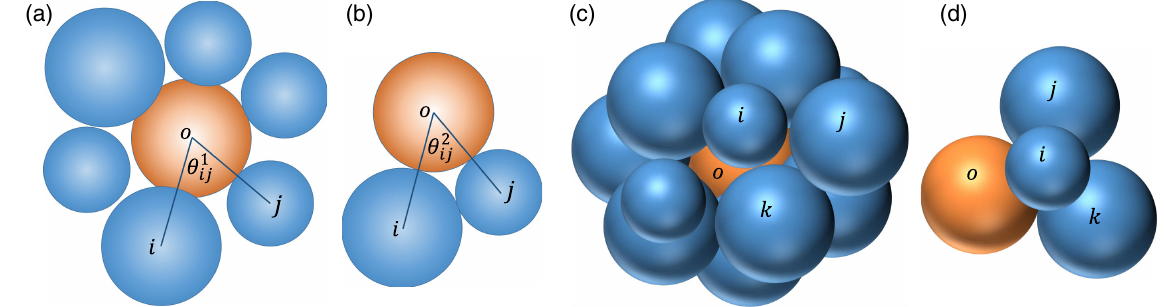
FIG. 1. Definition of the structural order parameter for binary systems. Left two panels: 2D binary disk system. (a) Illustration of a local configuration with a central particle o surrounded by its six neighbors, two of which are indicated as i and j . (b) Reference configuration with the three indicated particles just in touch. The definitions of central angles θ 1 respectively. Right two panels: 3D binary sphere system. (c) Illustration of a local configuration with a central particle o surrounded by its 14 neighbors, three of which are indicated as i , j , and k . (d) Reference configuration with the four indicated particles just in touch. See text for detailed definition of the structural order